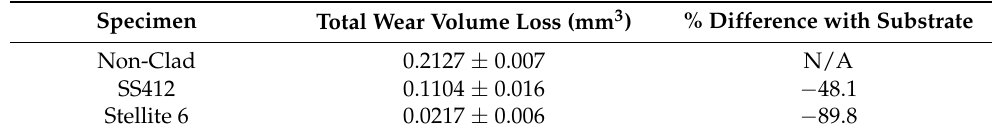
Table 4. Total wear volume loss for non-clad and cladded light rails after the rolling distance of 200